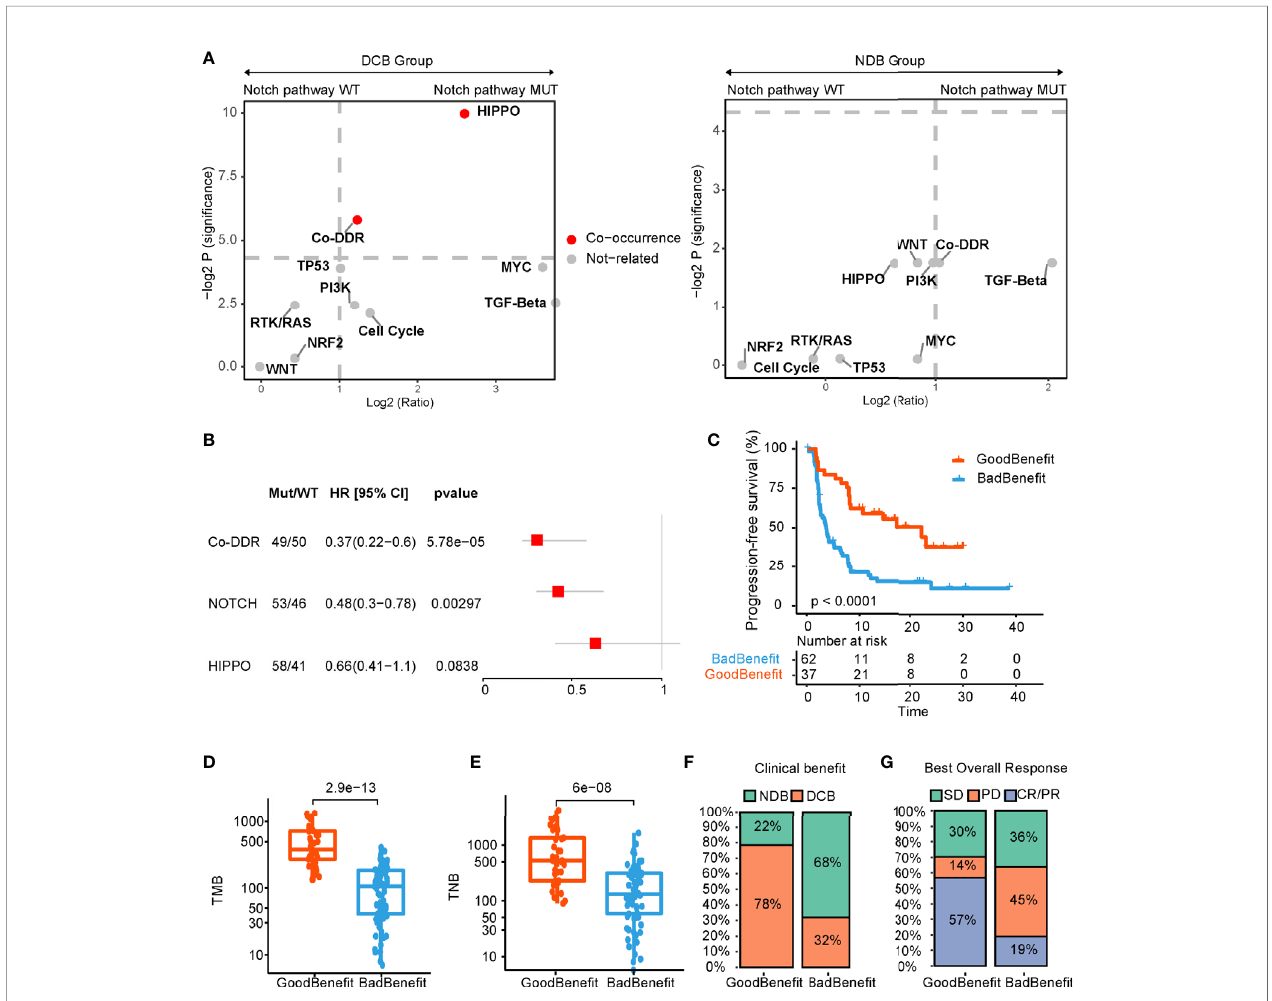
FIGURE 2 | NOTCH co-occurring pathways that contributed to ICI ef fi cacy. (A) log2 (odds ratio) and -log2 (p value) for enrichment of altered pathways co-occurred with and without NOTCH pathway. (B) Forest plot displaying univariate cox regression analyses for PFS of individually considered pathway. (C) Kaplan-Meier survival curves for PFS comparing “ GoodBene fi t ” versus “ BadBene fi t. ” (D, E) Boxplot of TMB (D) and TNB (E) in “ GoodBene fi t ” versus “ BadBene fi t. ” (F, G) Percentage of patients with clinical bene fi t evaluation (F) and objective response (G)